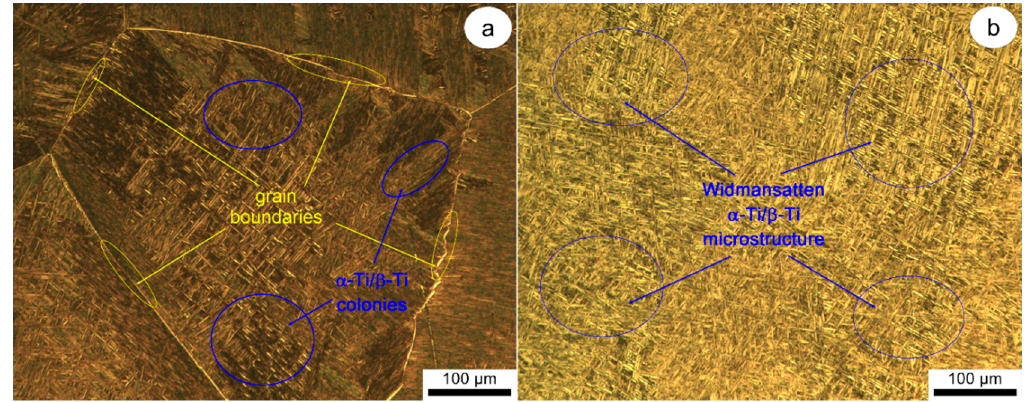
Figure 2. ( a , b ) Optical microscopy (OM) images of as-received (AR) state in different investigation areas.